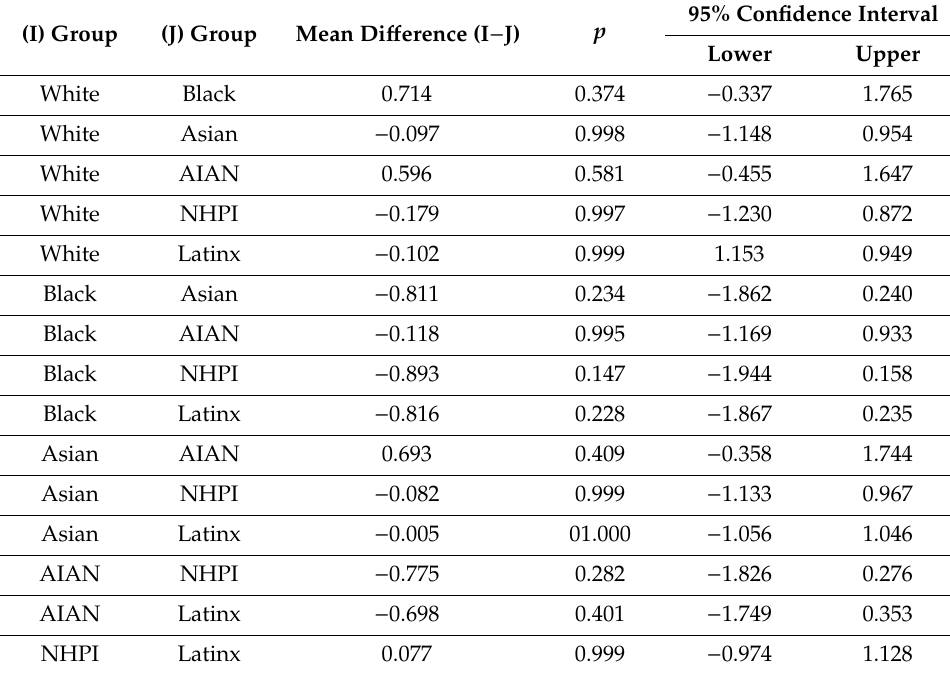
Table A3. Post-Hoc Comparisons for RQ